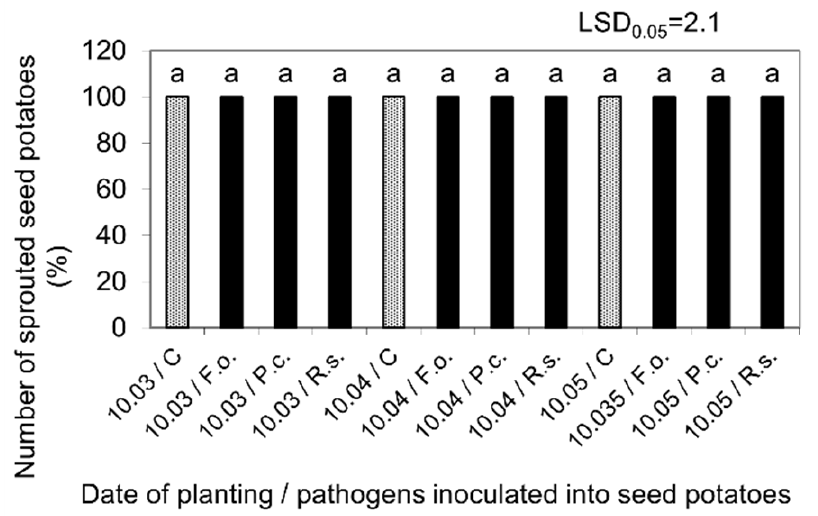
plants obtained from them, in the performed three cultivation periods presented, started to emerge 6 days after planting of the seed potatoes and grew for the next 72 days, reaching the final height of 80–85 cm and forming flower buds. The plants obtained from sprouted seed potatoes planted on 10 April and 10 May, developed correspondingly earlier and faster than those grown from mother tubers planted in March with dormant buds (Figure 4).